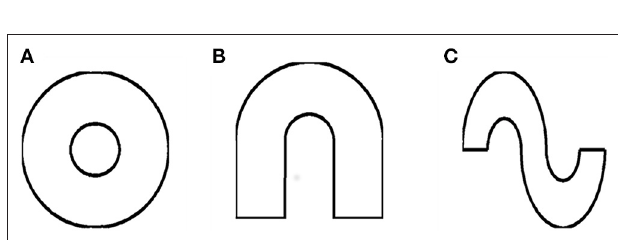
FIGURE 5 | Simulated concave shaped environments (A) Annulus, (B) Horseshoe, and (C) S-Shape, respectively.